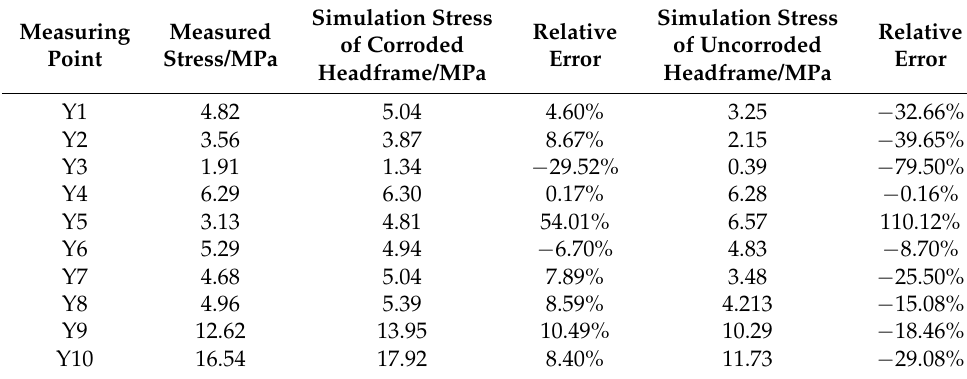
Table 1. The stress results of each measuring